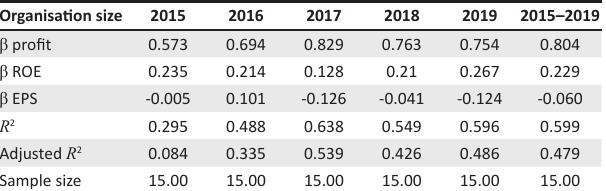
TABLE 6: Multiple regression – Organisation performance on chief executive officers’ total remuneration.